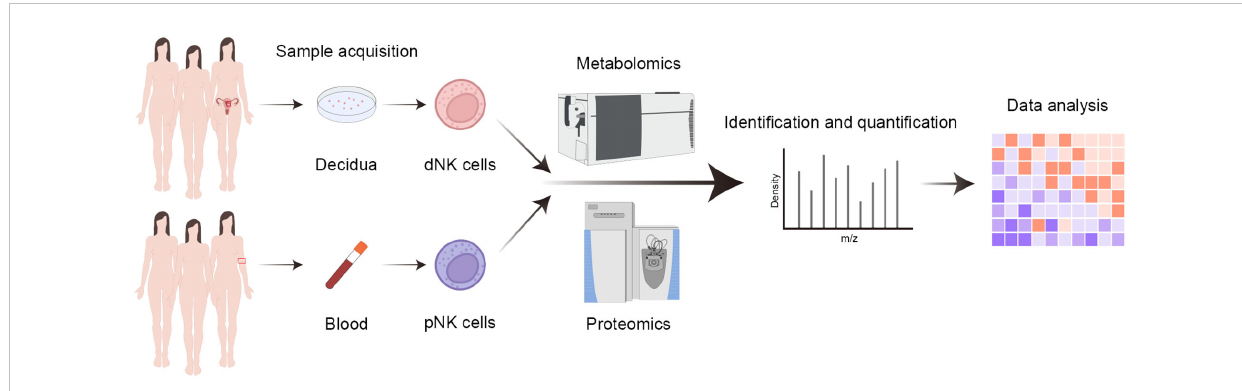
FIGURE 1 Work fl ow of proteomics and metabolomics. Summary for the analysis of blood and decidual samples by mass